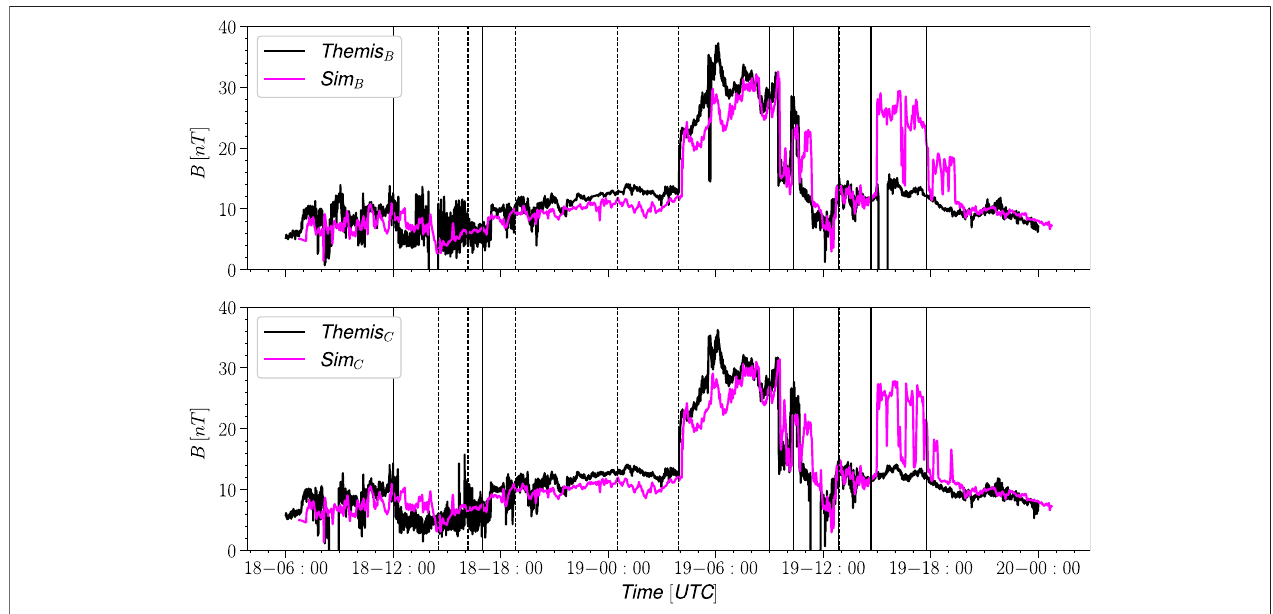
FIGURE 4 | Magnetic fi eld magnitude trace observation (black) vs simulation (magneta) Themis B and C.